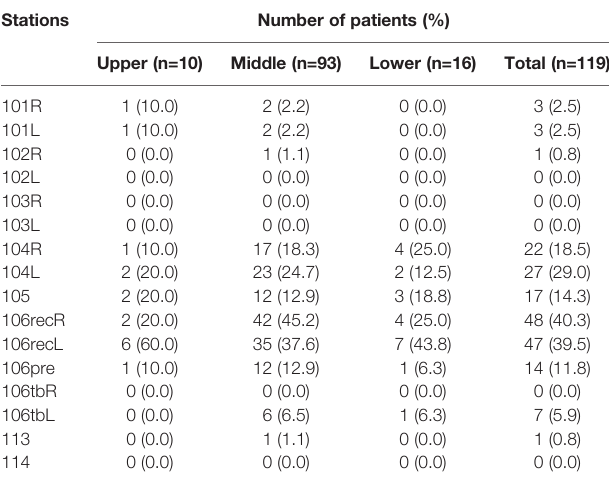
TABLE 2 | Frequency of LNR and percentage of patients with LNR at different stations for 119 TESCCs.